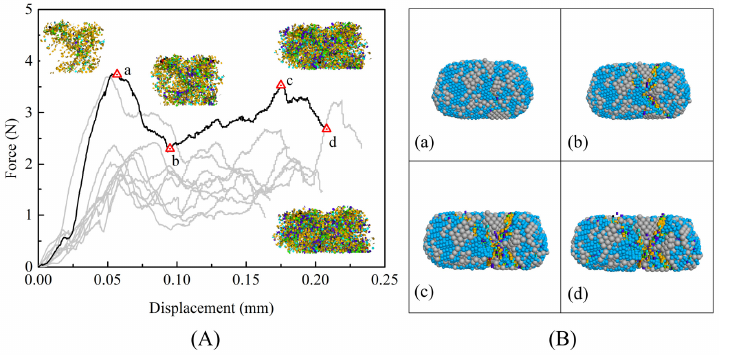
Figure 8. DEM results of single particle crushing tests for a realistic short rod particle: ( A ) force–displacement curves and spatial distribution of different microcracks; ( B ) particle states of the loading process. ( a ) elastic limit; ( b ) yield minimum; ( c ) breakage peak; ( d ) finial